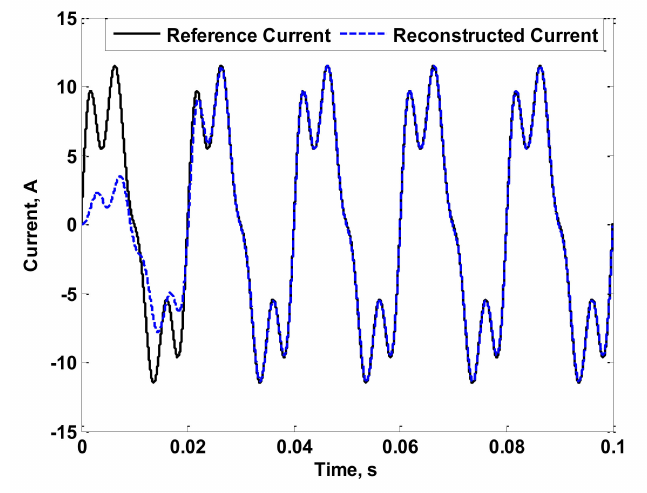
Figure 7. Reference and Reconstructed Currents of the Simulated Coil.